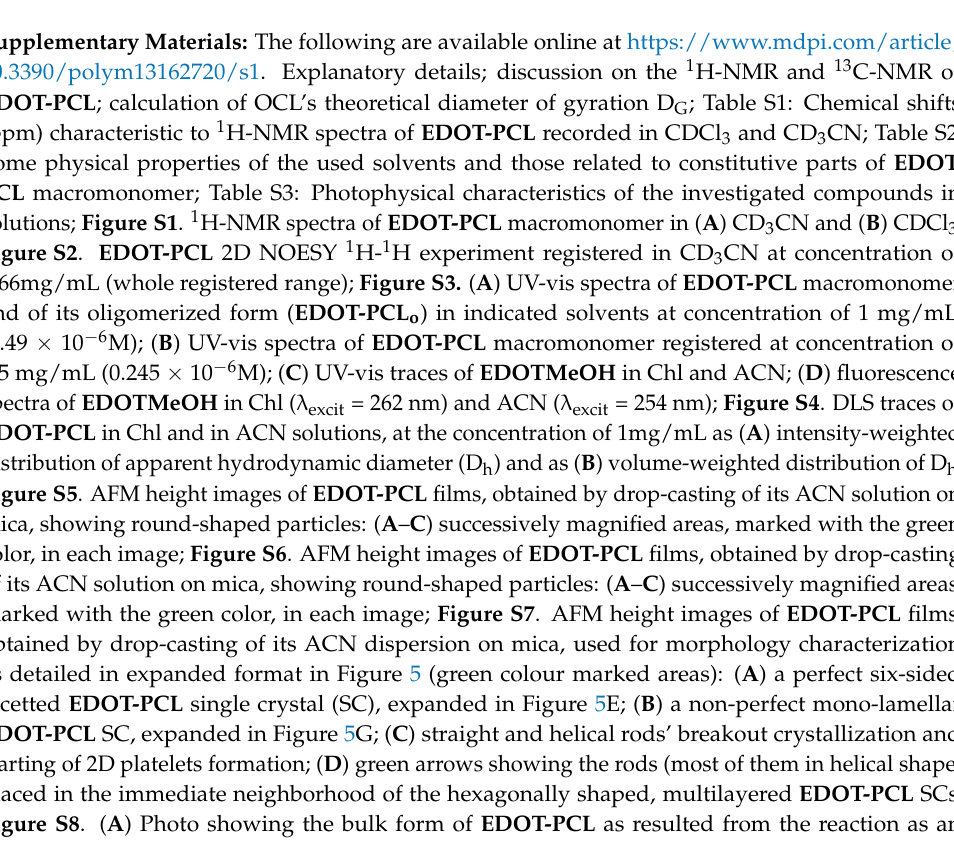
solutions; Figure S1 . 1 H-NMR spectra of EDOT-PCL macromonomer in ( A ) CD 3 CN and ( B ) CDCl 3 ; Figure S2 . EDOT-PCL 2D NOESY 1 H- 1 H experiment registered in CD 3 CN at concentration of 6.66mg/mL (whole registered range); Figure S3. ( A ) UV-vis spectra of EDOT-PCL macromonomer and of its oligomerized form ( EDOT-PCL o ) in indicated solvents at concentration of 1 mg/mL, (0.49 × 10 − 6 M); ( B ) UV-vis spectra of EDOT-PCL macromonomer registered at concentration of 0.5 mg/mL (0.245 × 10 − 6 M); ( C ) UV-vis traces of EDOTMeOH in Chl and ACN; ( D ) fluorescence